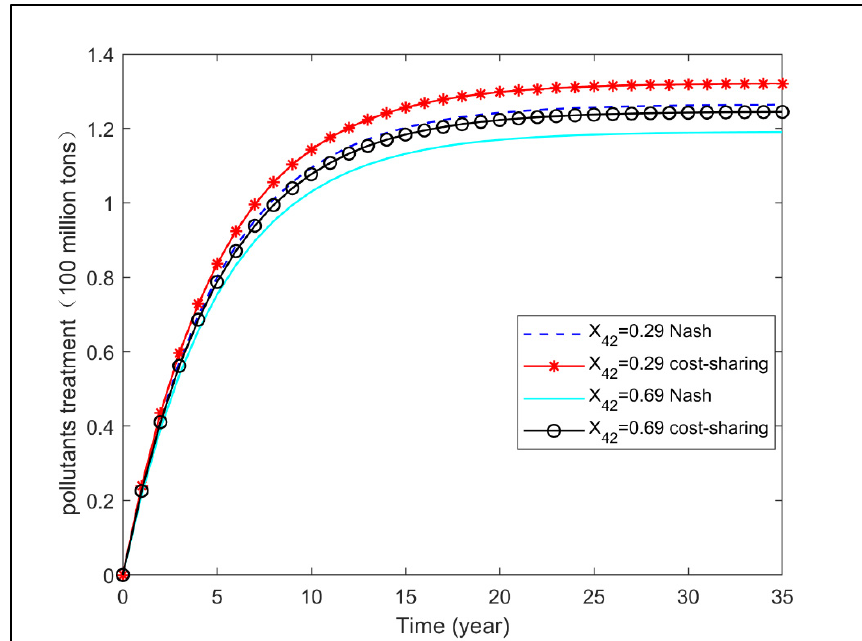
Figure 12. The Shanxi province effects on pollutants treated.